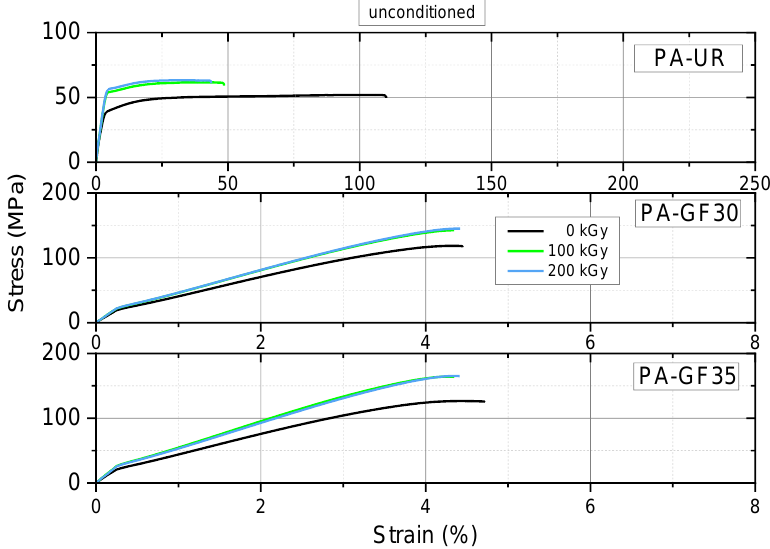
Figure 9. Tensile stress – strain curves for three PA grades in the as-received condition at 23 °C depicting the effect of irradiation dose.